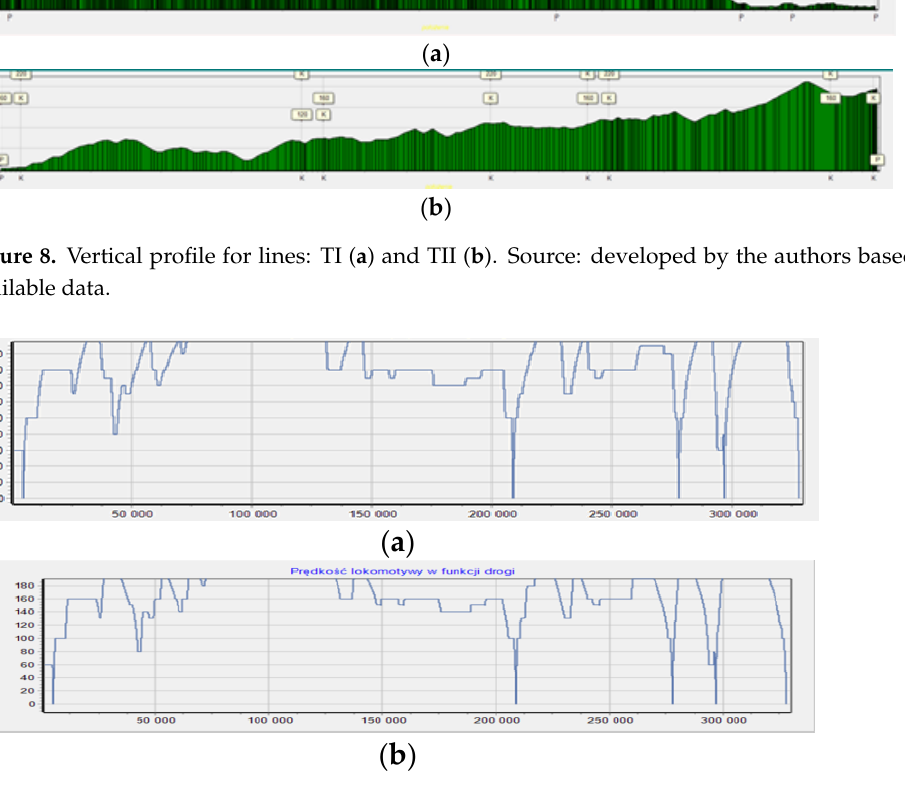
Figure 9. Trains speed profile on TI line ( a ) direction W-Gd and ( b ) direction Gd-W. Source: devel- oped by the authors-results of simulations.